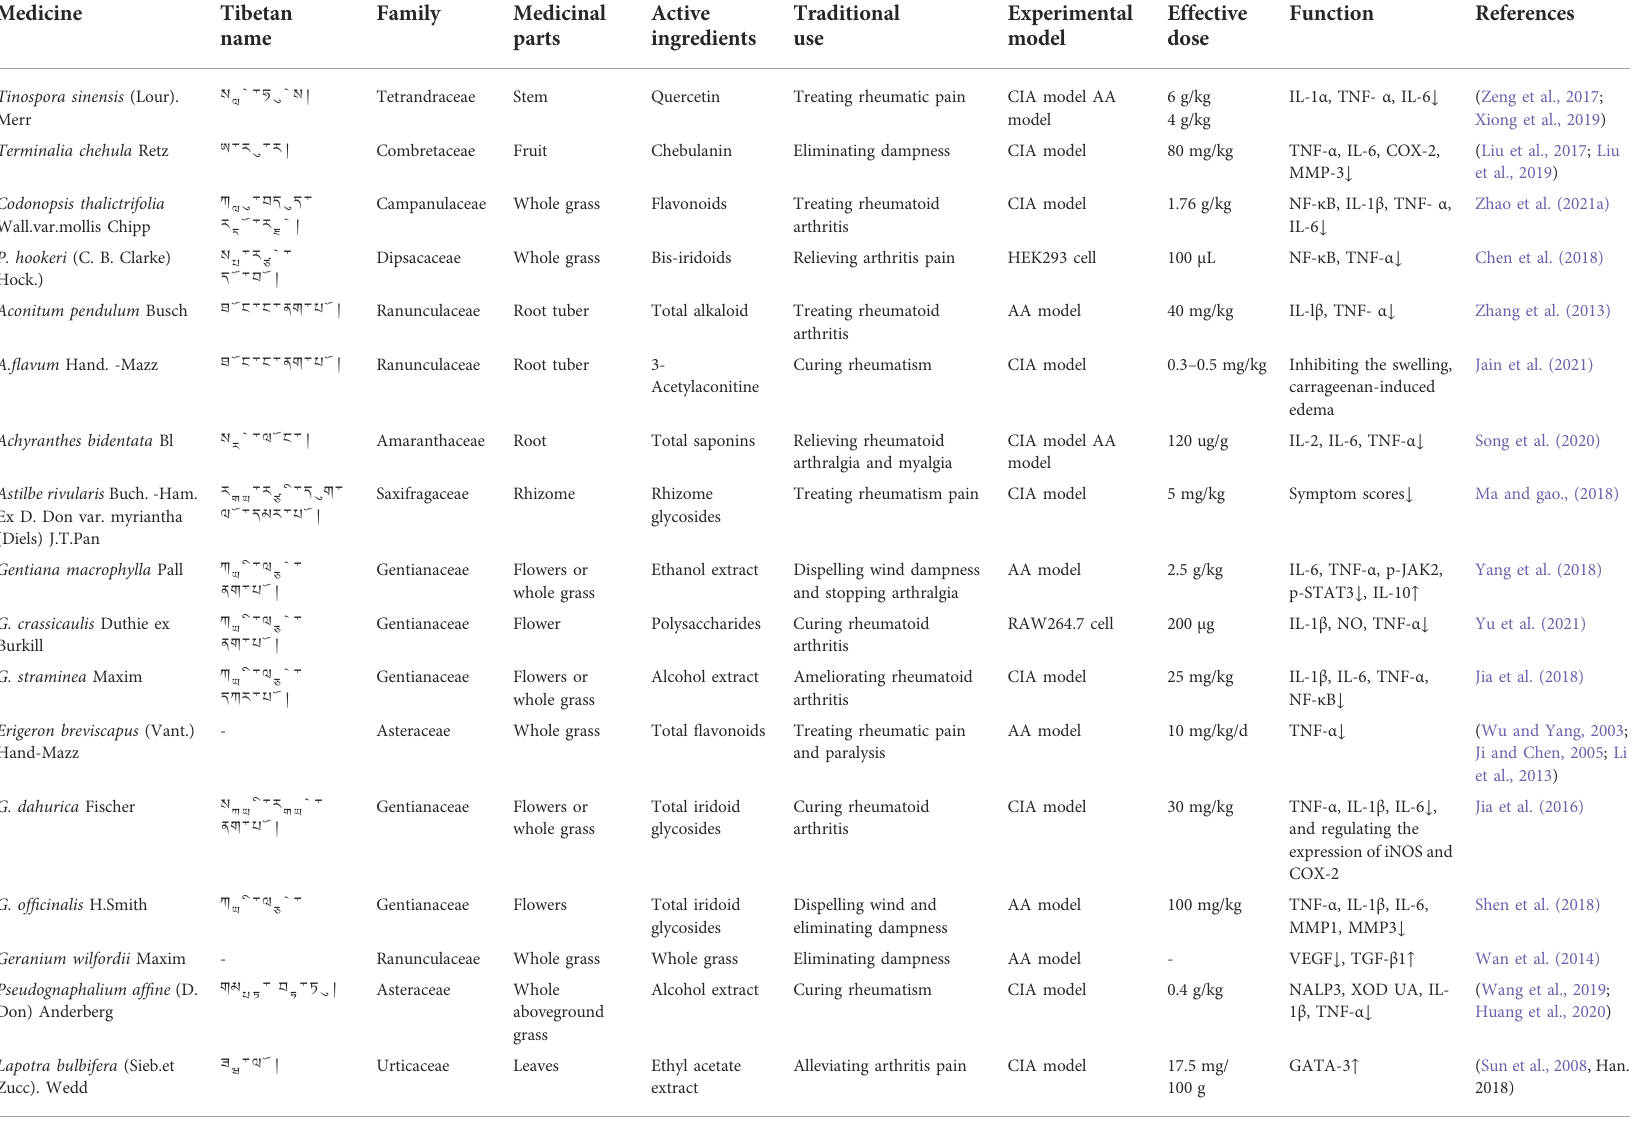
TABLE 1 Tibetan medicine for anti-RA (Tibetan medicine names are ranked from high to low in the frequency of